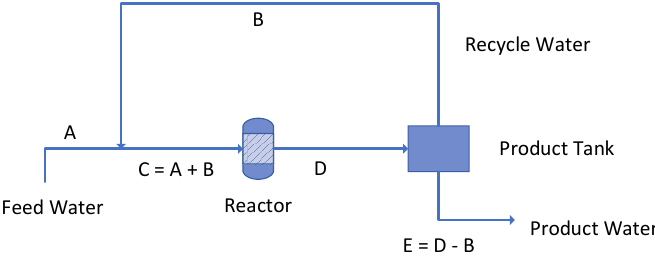
Figure A4. Fluid volumes associated with individual flow lines when the reactor incorporates a recycle loop. A = feed water (groundwater) flow rate, m 3 d − 1 ; B = recycle water flow rate, m 3 d − 1 ; C = water entering the reactor, m 3 d − 1 ; D = water leaving the reactor, m 3 d − 1 ; E = product water (partially desalinated irrigation water) flow rate, m 3 d − 1